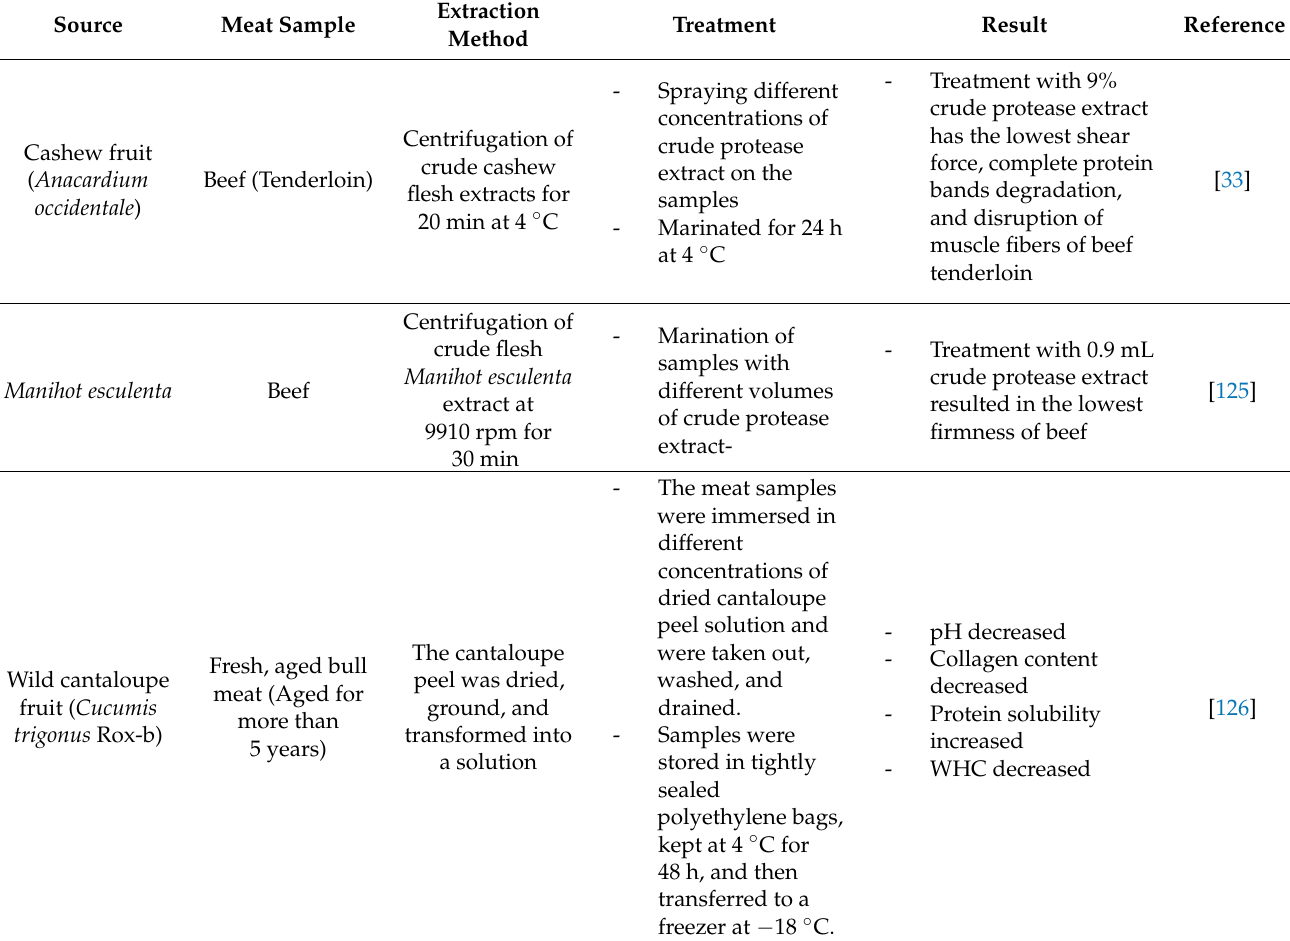
Table 3. Novel sources of plant protease for meat